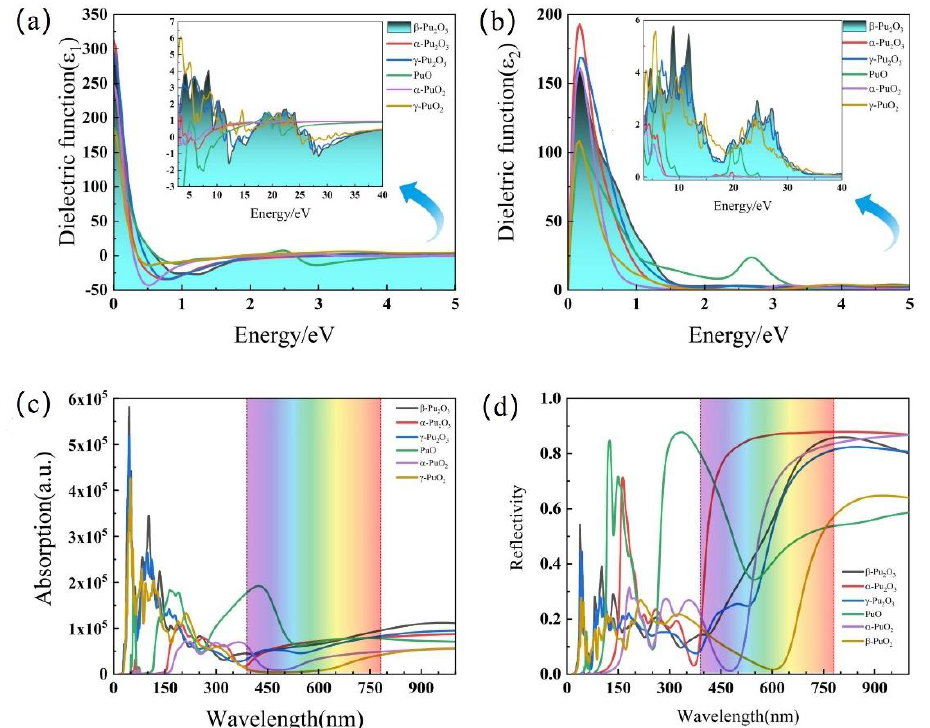
Figure 4. Real 𝜀 1 (𝜔) , imaginary 𝜀 2 (𝜔) components of the dielectric function in ( a , b ). ( c ) shows Figure 4. Real ε 1 ( ω ) , imaginary ε 2 ( ω ) components of the dielectric function in ( a , b ). ( c ) shows light light absorption spectra and ( d ) shows reflection spectra of studied oxide. absorption spectra and ( d ) shows reflection spectra of studied